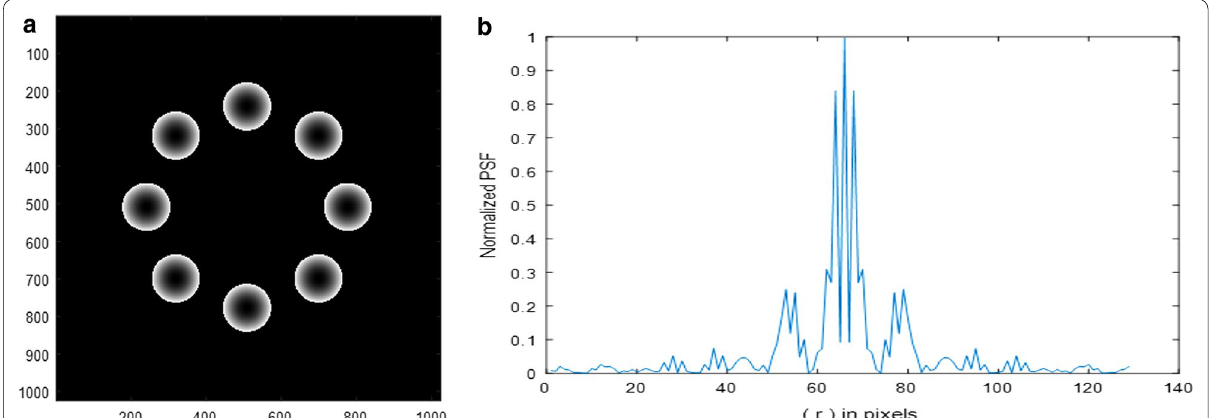
268 pixels from the center placed at (512, 512). The =